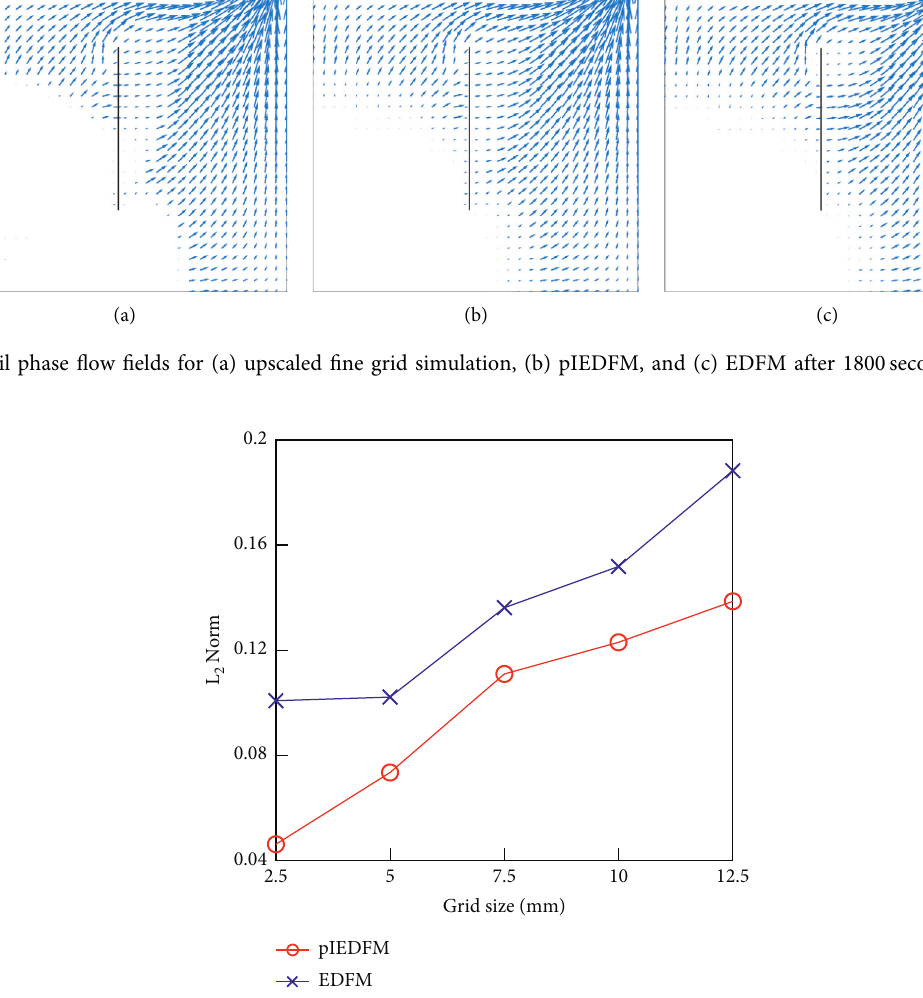
Figure 16: L 2 norm against grid